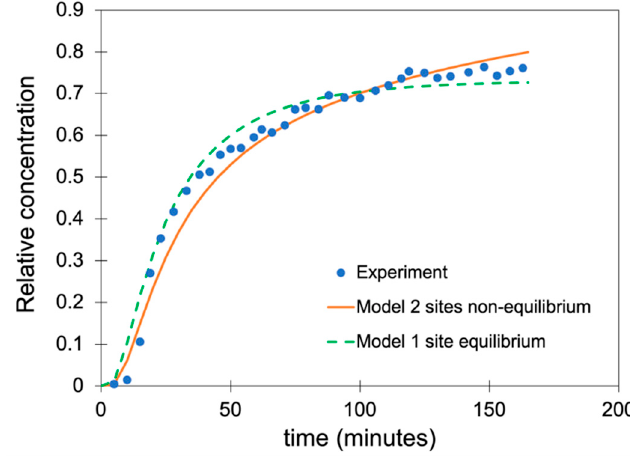
Figure 9. Comparison of the one site and two sites models to fit a 1000 mg L − 1 TC transport experiment.